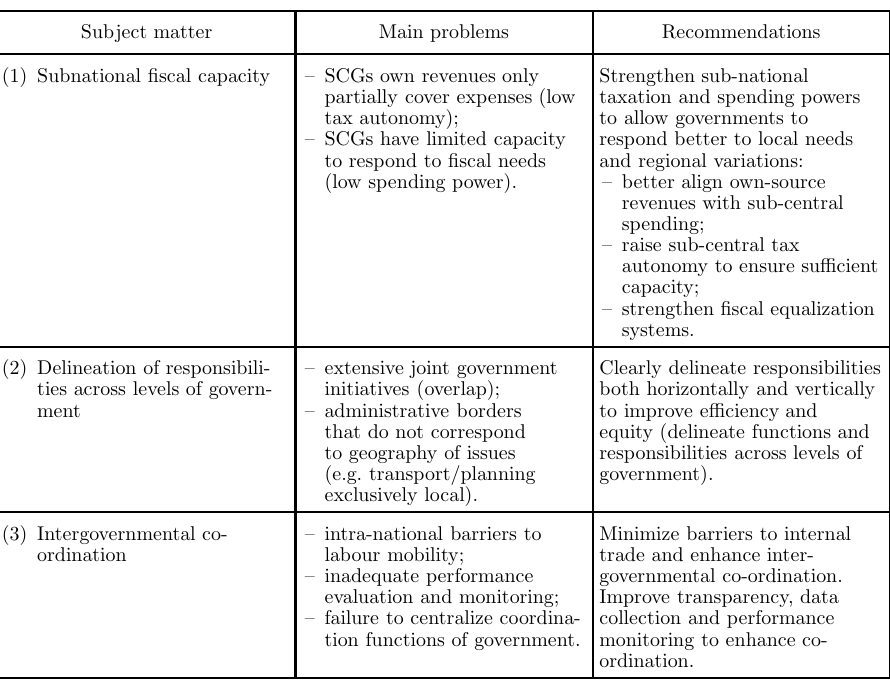
Linking COVID-19 to typical policy recommendations on fiscal